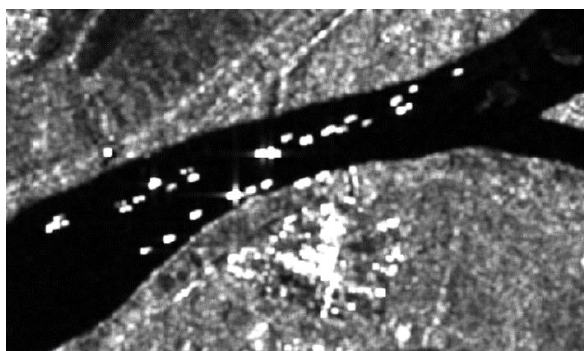
Figure 14. Vessel situation (1) - Zimnicea – 09.08.2015 -